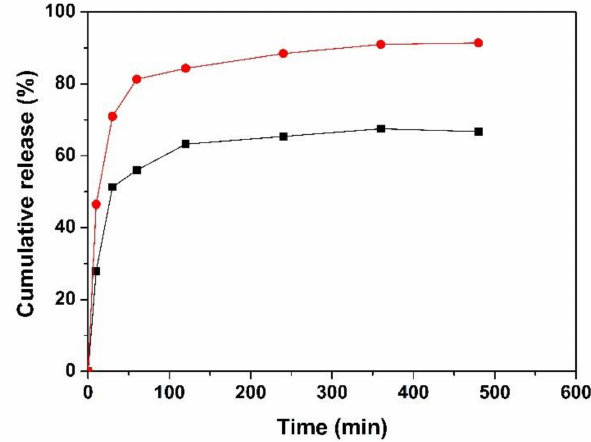
Figure 5. Release of 2,4-D from the CMCS-DEACMS-2 micelles under simulated sunlight irradiation ( • ) and drak ( (cid:4)